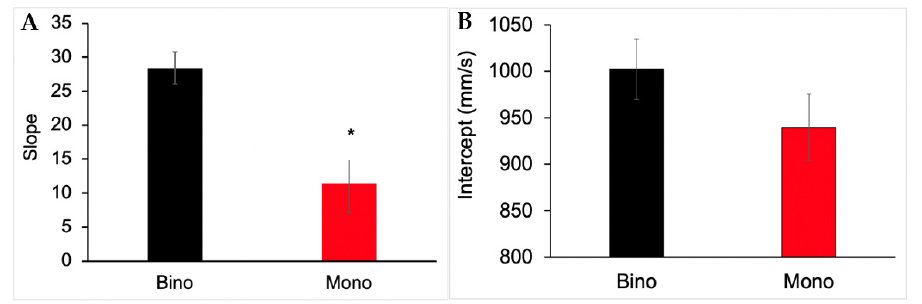
Figure 6 . Mean slope ( A ) and intercept ( B ) values from a regression analysis relating peak velocity with distance for reaching during binocular and monocular viewing conditions. Slope was significantly higher during binocular viewing (* p < 0.05). Error bars show ±1 standard error.